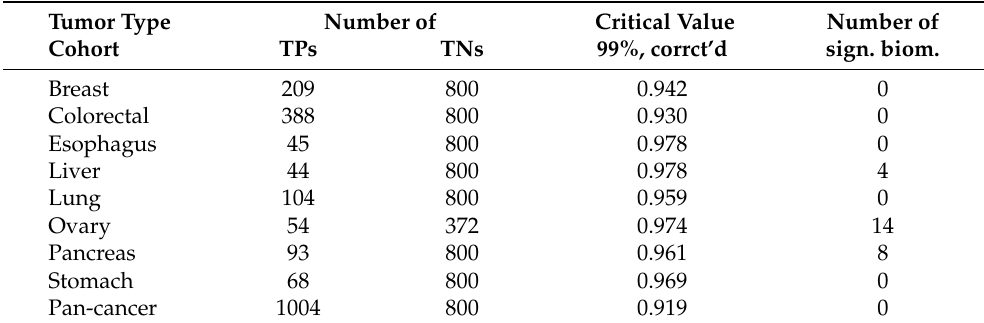
Table 1. Critical values for two-protein biomarkers. One-sided 99% critical values relative to the null-hypothesis that the biomarker has an AUC-value on par with the colorectal cancer test FIT, which has AUC 0.88, Bonferroni-corrected for the simultaneous testing of 53,352 hypotheses. The numbers of TPs and TNs account for some missing values.